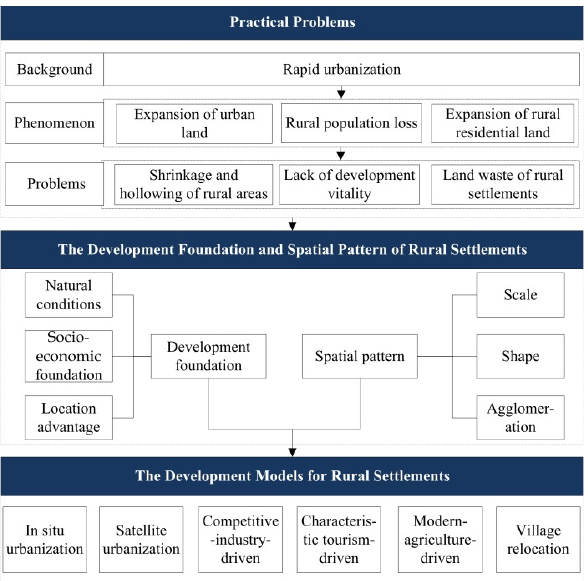
Figure 2. The framework of the theoretical development model for rural